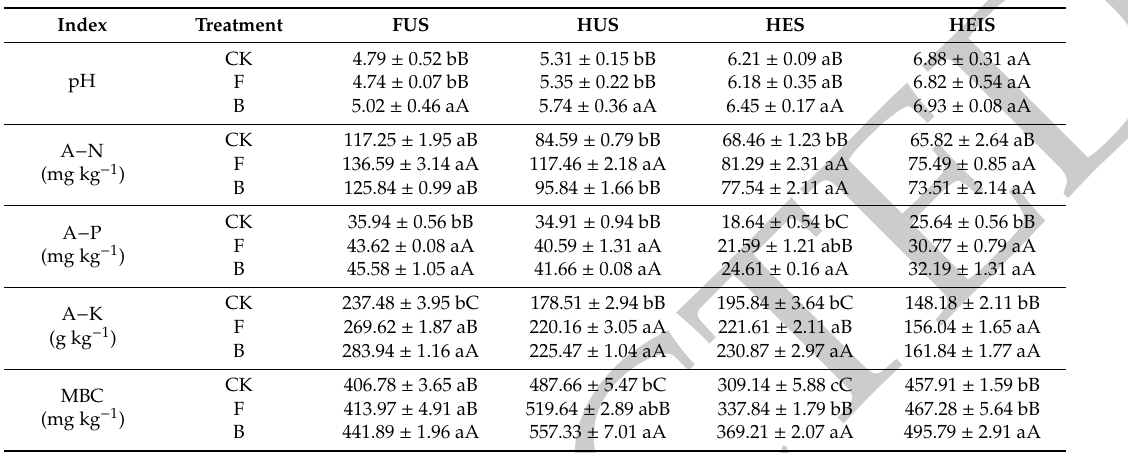
Table 4. E ff ects of biochar on the chemical properties of tobacco-planting